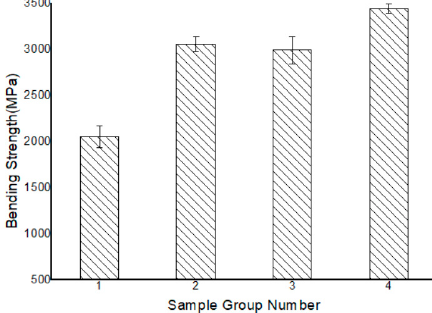
Figure 4. Bending strength of WC–Co cemented carbide.